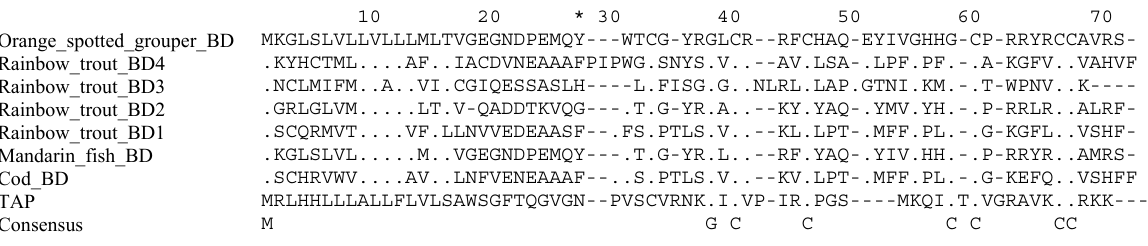
Figure 2. Alignment of β -defensins. Precursor peptide sequences were obtained from published data and from the PubMed protein database, and were aligned using MacVector software. The bovine β -defensin, Tracheal Antimicrobial Peptide (TAP) is shown for comparison. The conserved β -defensin cysteine spacing is shown in the consensus